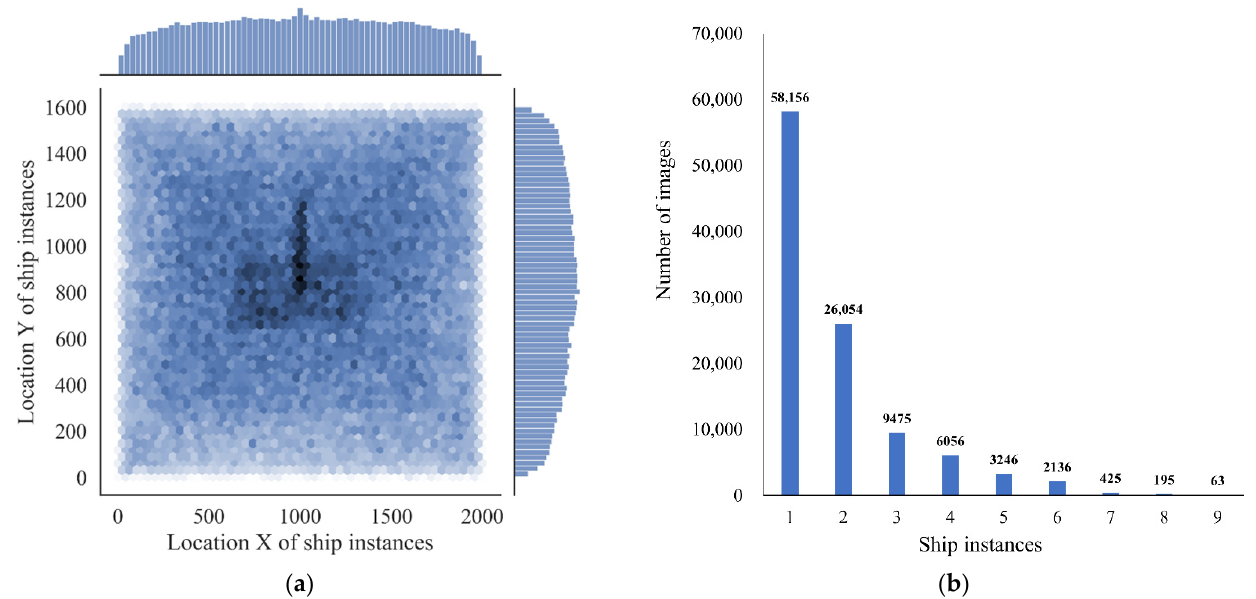
Figure 7. Location distribution ( a ) and density distribution ( b ) of ship instances.